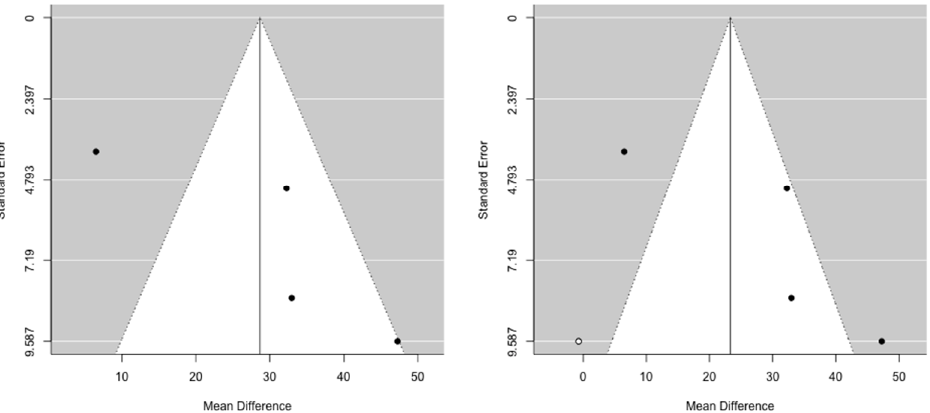
Figure 4. Funnel plots for mean difference in overall survival. Left: original data; Right: imputation of missing studies.